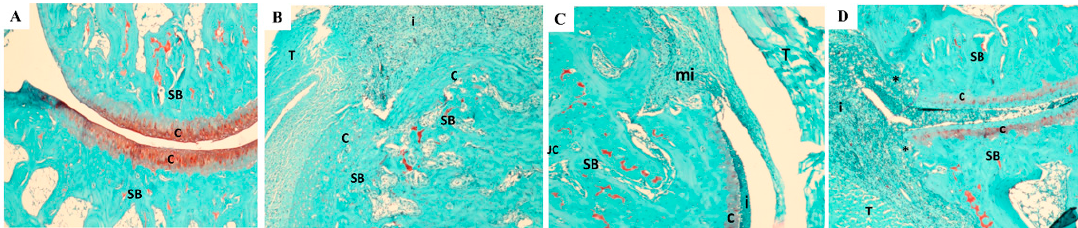
Figure 13. Microscopic changes in safranin staining. ( A ). Normal Control + Vehicle: Safranin 50 × – Histology of the hock with minimal pathology. SB–subchondral bone (green), c–cartilage (red orange); ( B ). CIA + Vehicle: 50 × Safranin: Diffuse necrosis of cartilage (c) and subchondral bone (SB). i–inflammation, T–tendon. The lack of red-orange staining on articular surfaces highlights the cartilage loss. Expanded by edema and infiltrated by inflammation; ( C ). CIA + Methotrexate: 50 × Safrarin; These images demonstrate an area of fibroplasia with monocytic inflammation (mi). SB–subchondral bone, C–cartilage with adhered inflammation (i), T–Tendon; JC: joint capsule lined by synovium. ( D ). CIA + UP1306: 50 × Safranin–Subchondral bone (SB) with the overlying cartilage (c) and adjacent bone being effaced (*) by inflammation; (i) T–tendon expanded by edema and infiltrated by